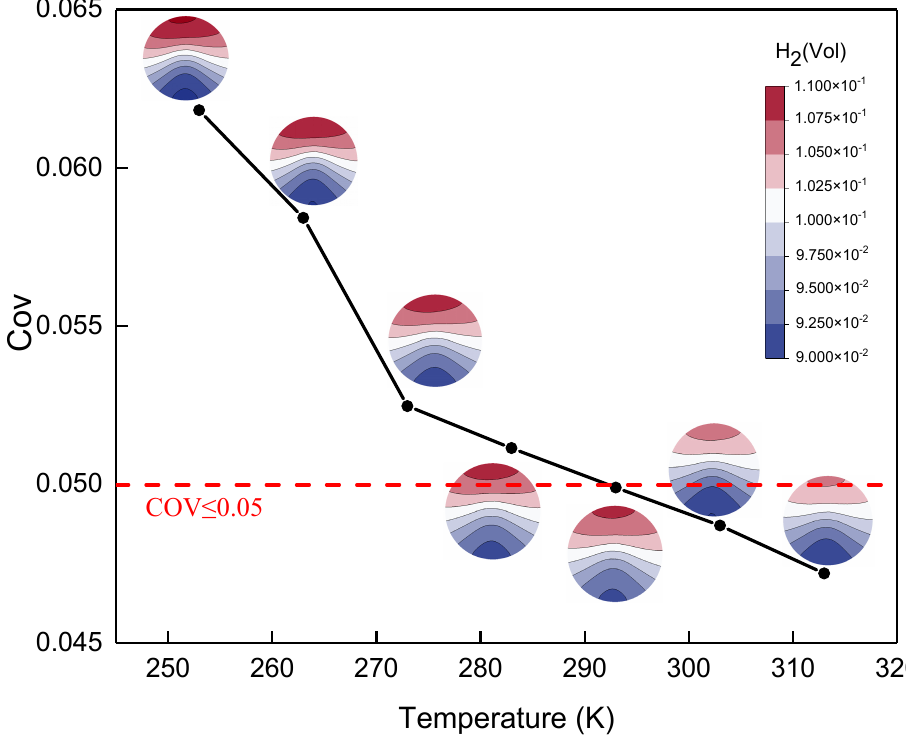
Figure 9. COV at the flow distance of z = 40 D (40th cross section) under different gas tempera- tures.